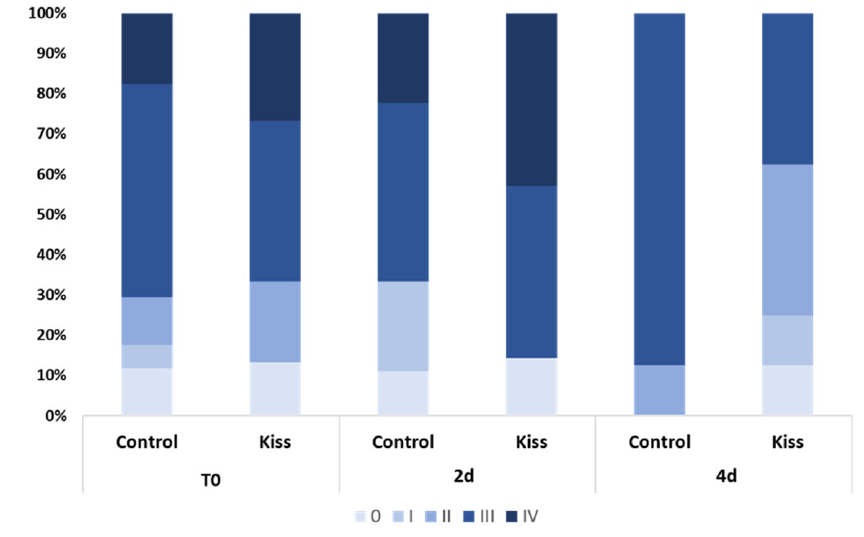
Figure 1. Percentage of gonad maturation stages (0 to IV) in Senegalese sole females treated with kisspeptin hormone ( n = 15) and untreated controls ( n = 17) before (T0) and after (2 d: 2-days, 4 d: 4-days) kisspeptin injection.